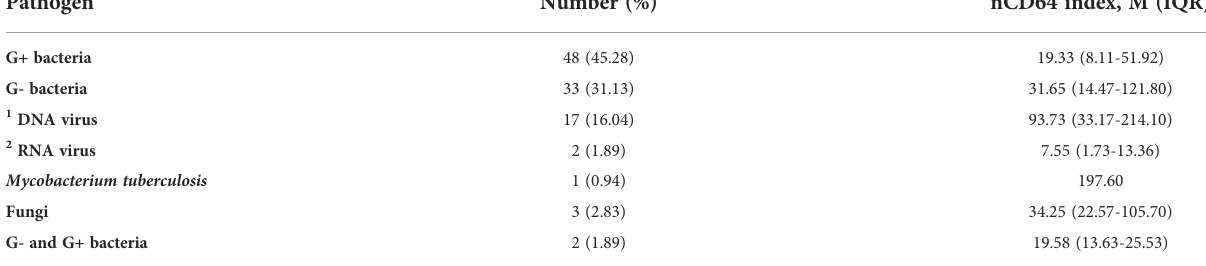
TABLE 2 Pathogens of bloodstream infections.